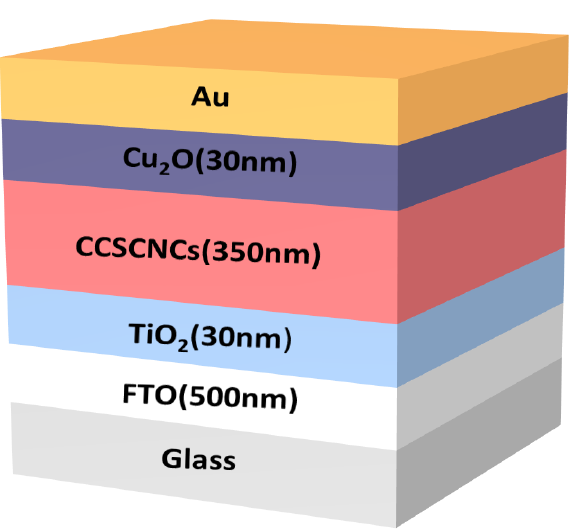
Figure 18. Schematic of the optimized device with FTO/TiO 2 /CCSCNCs/Cu 2 O/Au structure.